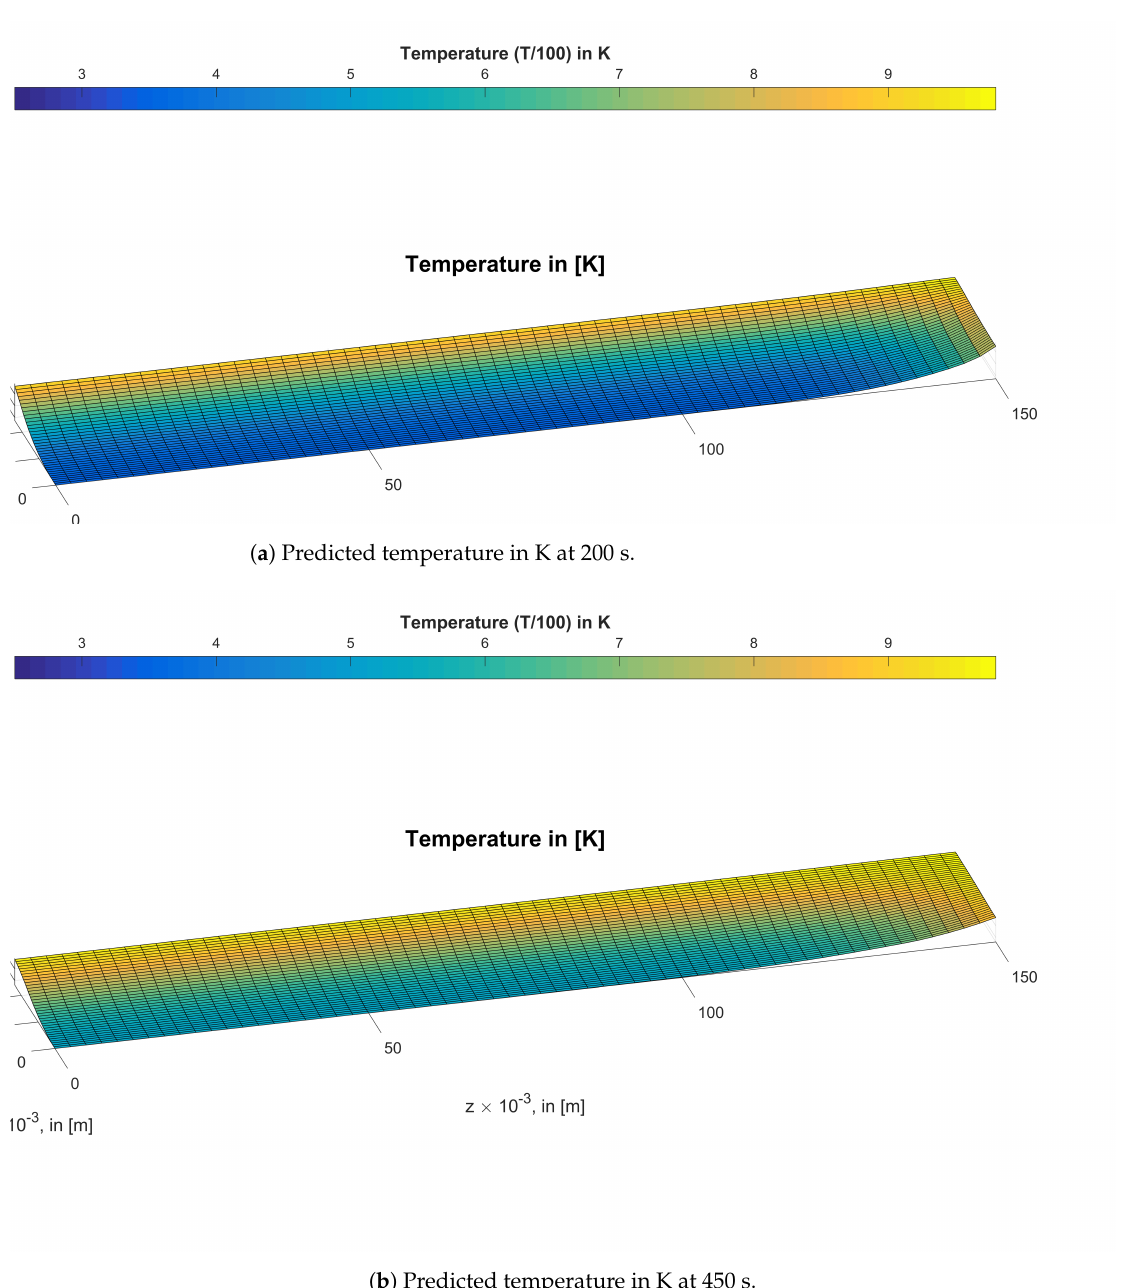
Figure 3. Wood internal temperatures in K at 200 s and 450 s during devolatilization. The top of the wood log is at z = 150 mm, and the lateral shell surface of the wood log is at r = 25